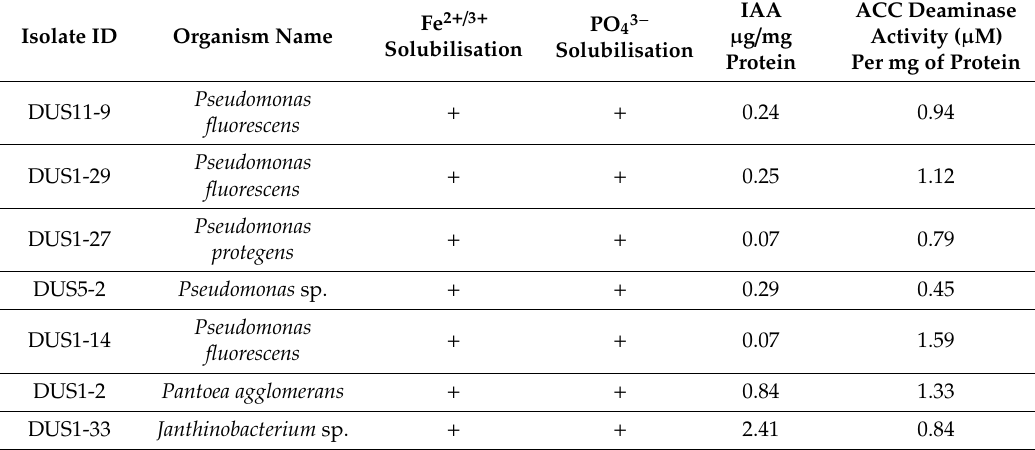
Table 1. Isolate capacity to solubilise both Fe 2 +/ 3 + and PO 43 − , production of Indole-3-acetic acid (IAA) and 1-aminocyclopropane-1-carboxylate (ACC), and deaminase